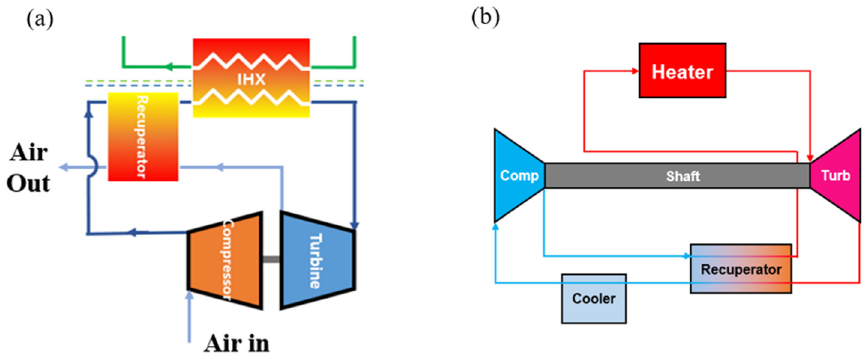
Figure 2. Cycle layout for ( a ) open-air Brayton and ( b ) closed S-CO 2 Brayton cycle.